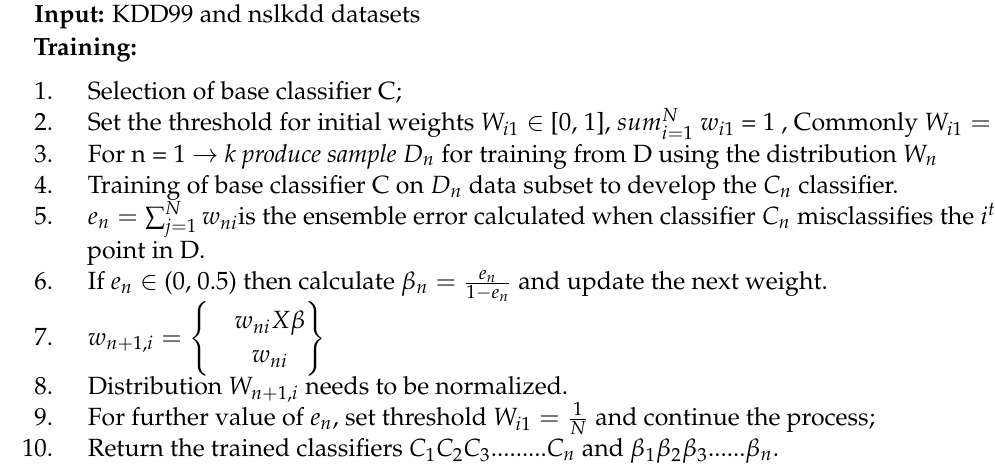
Algorithm 3: Adaboost classifier